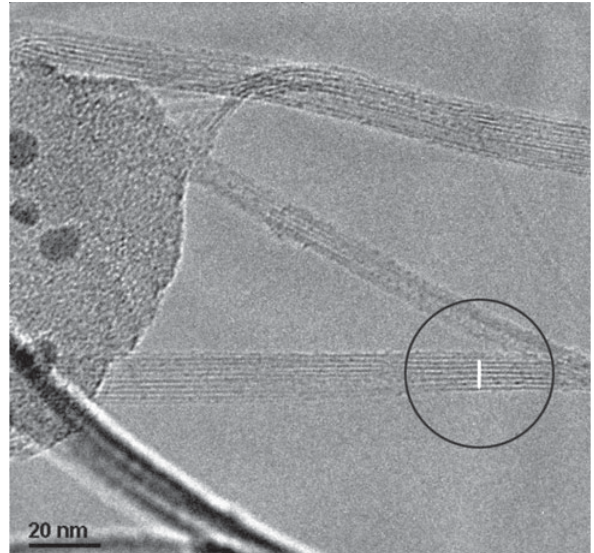
Figure 2. High magnification HRTEM image of SWCNTs pro- duced using the catalyst mixture: LiNi charge method.